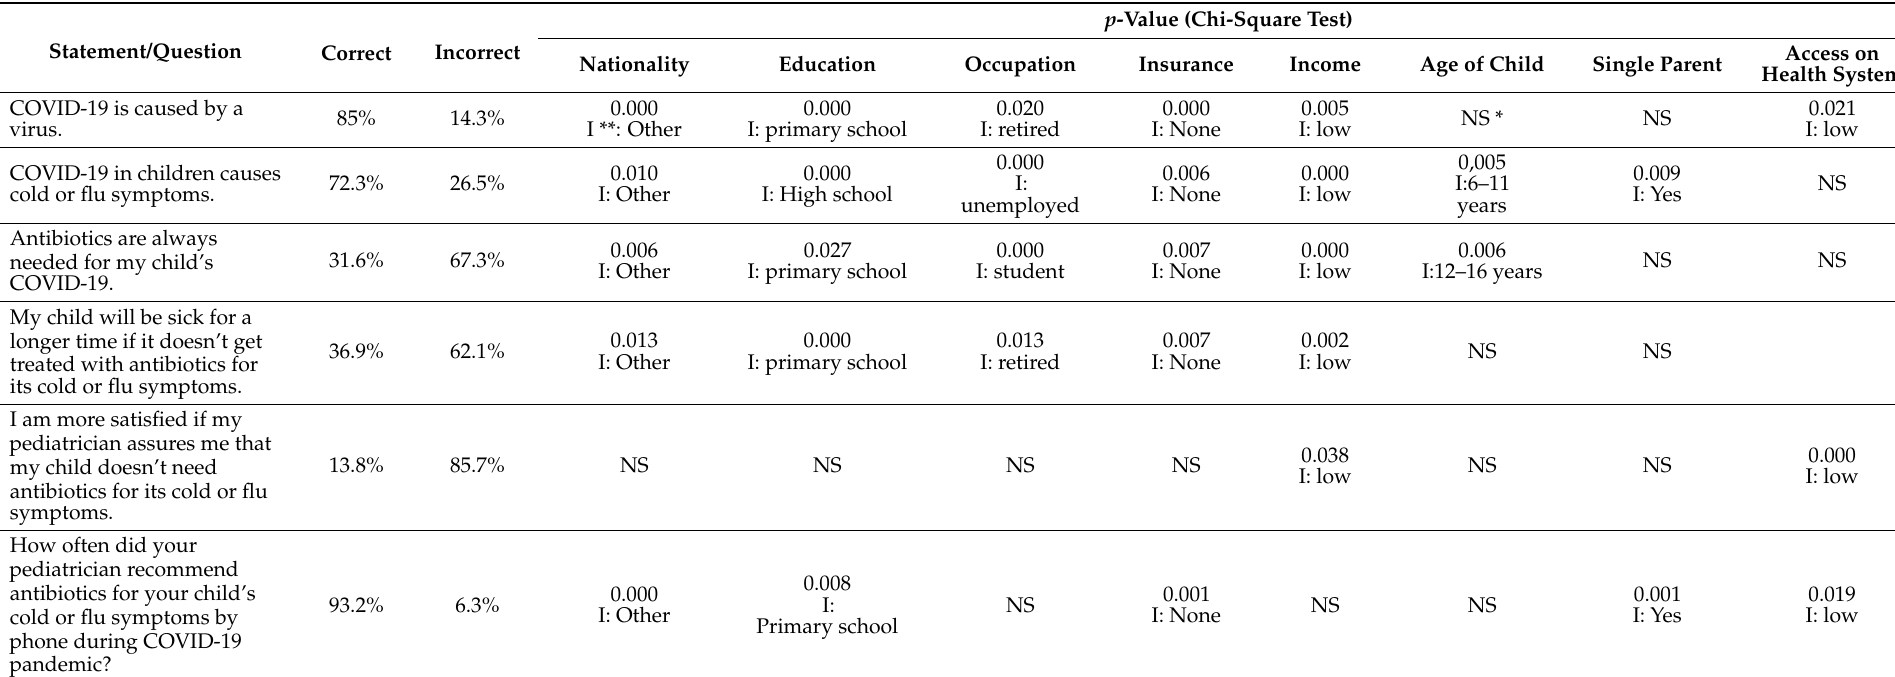
Table 2. Association of demographic characteristics with knowledge/attitude/practice statements on